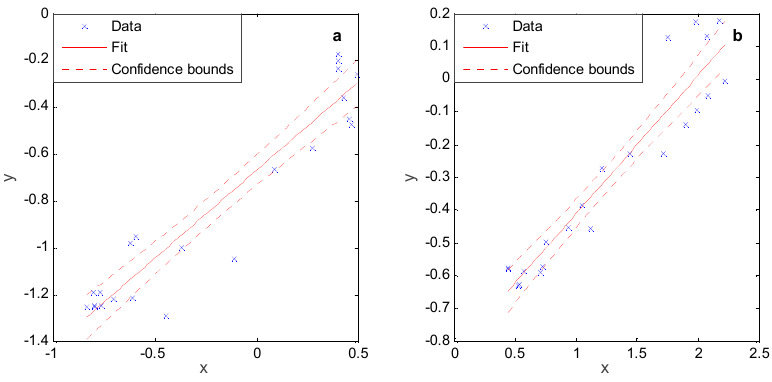
Figure 3. Parameters β 0 and β 1 estimated at desert ecosystems ( a ) and oasis farmland ( b ).